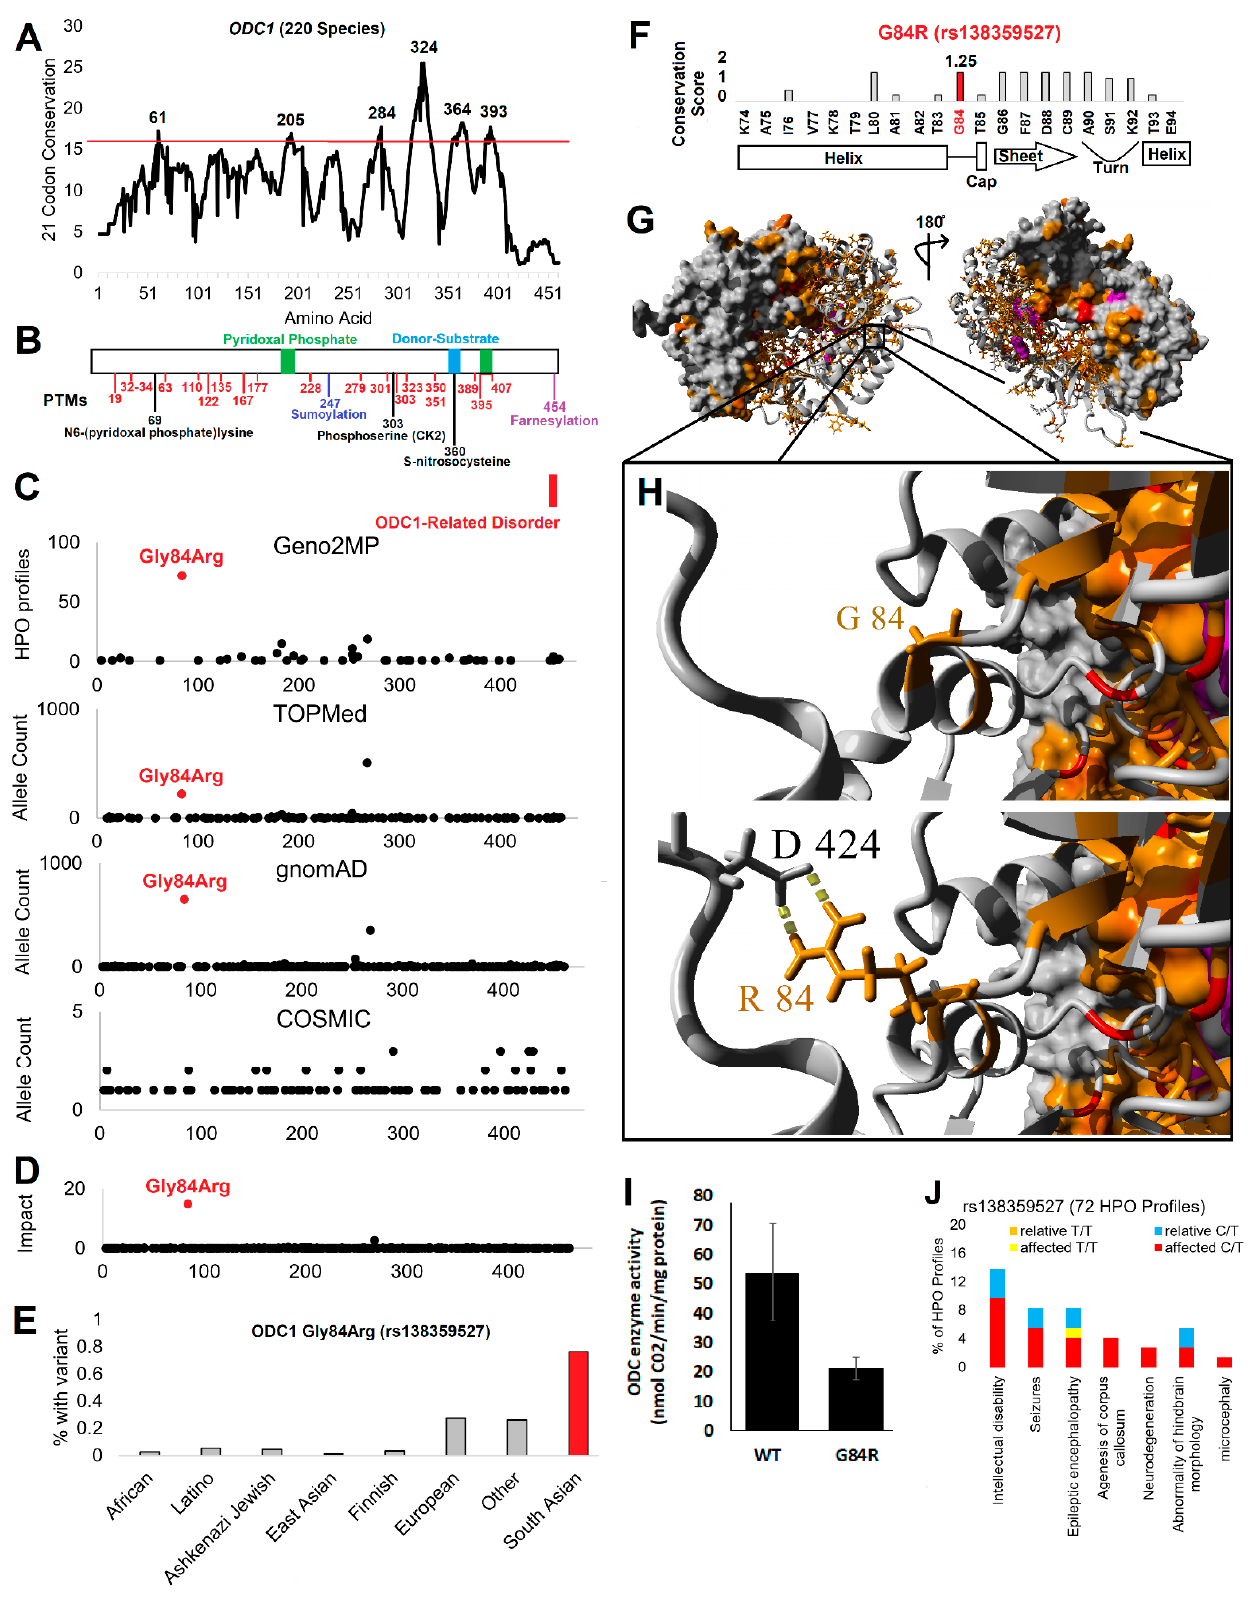
Figure 1. ODC1 missense variant screen. ( A ) Using 220 open reading frame sequences a 21-codon window for conservation was assessed for conserved motifs. The top six are labeled with the highest scored amino acid within the motif labeled. ( B ) Pictorial of ODC binding sites and posttranslational modifications. Known modifications are shown in black,